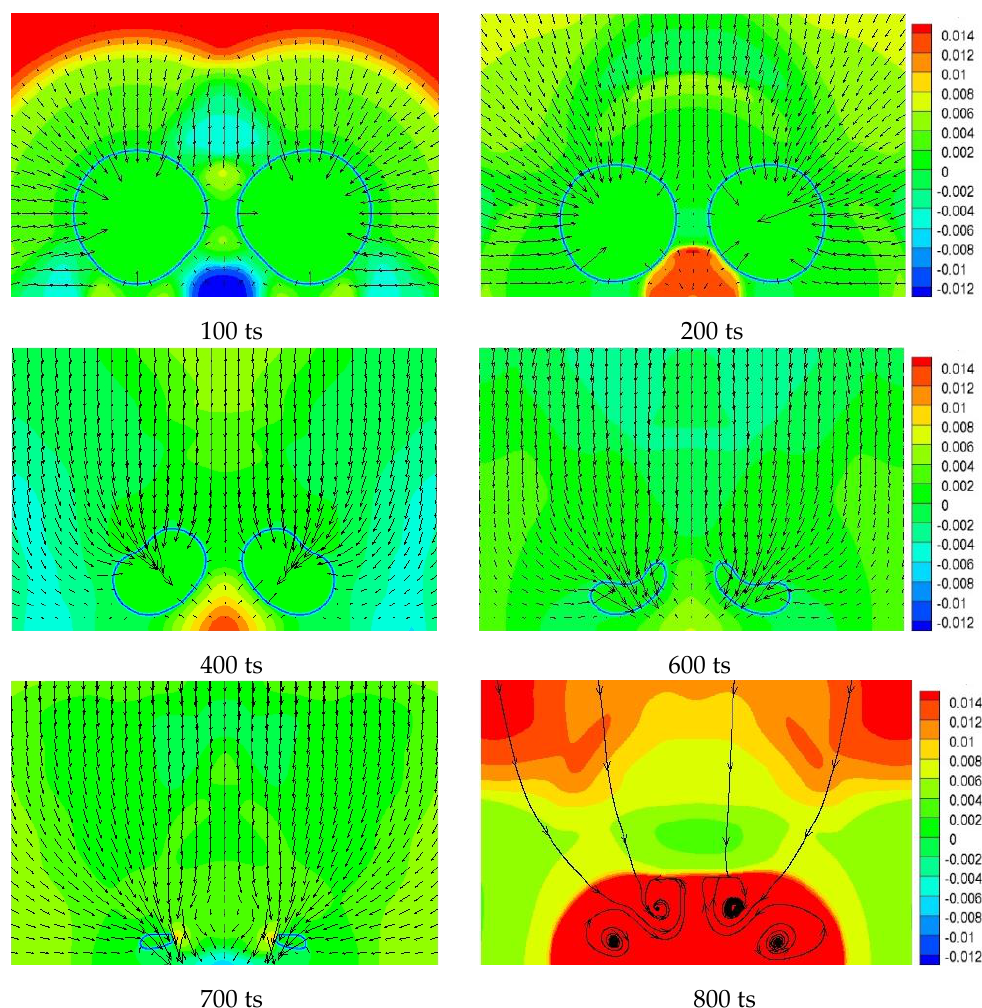
Figure 10. Pressure field and velocity field of cavitation bubble collapse (800 ts is the pressure field and streamline diagram).